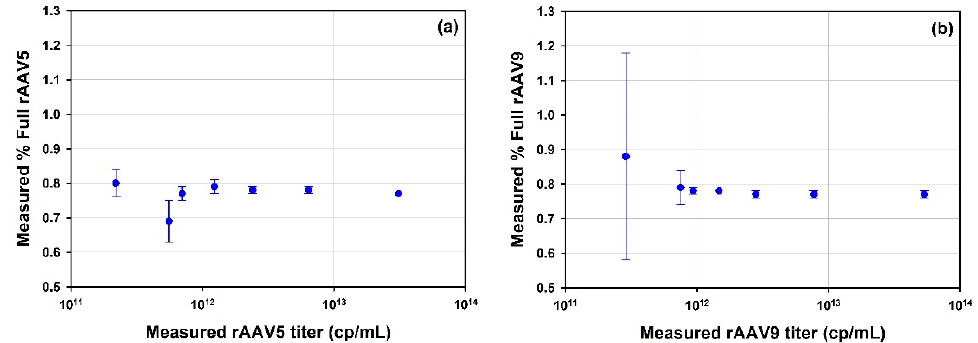
Figure 8. Plots of measured % full rAAV as a function of the measured rAAV titer (cp/mL); ( a ) rAAV5; ( b ) rAAV9.